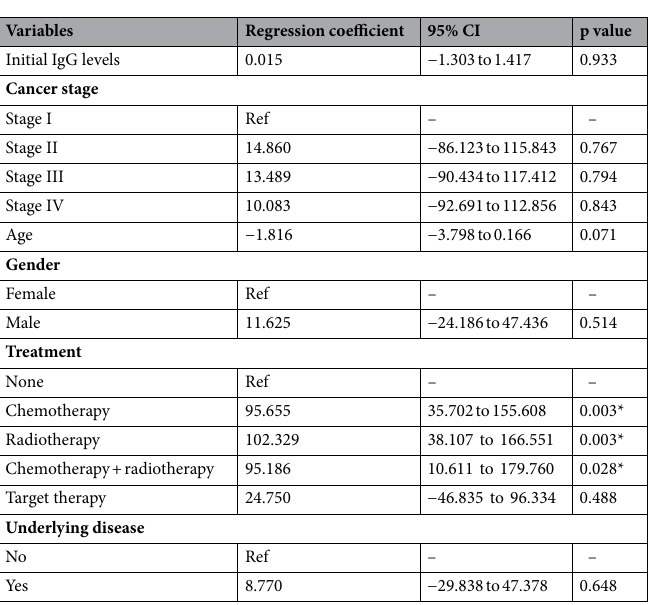
Table 2. Factors that affect the duration of anti-SARS-CoV-2 IgG antibody in cancer patients recovered from COVID-19 as analyzed with linear regression model. *p value less than 0.05 means statistically significant. CI confidence